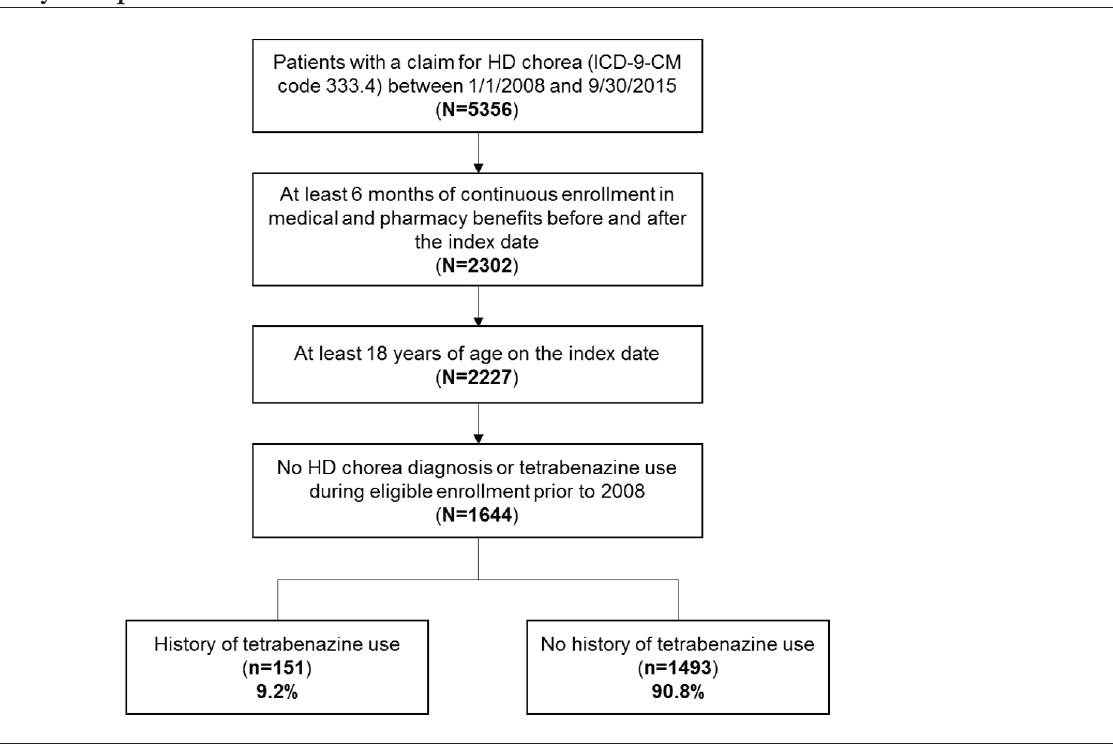
Figure 1. Study Sample Selection